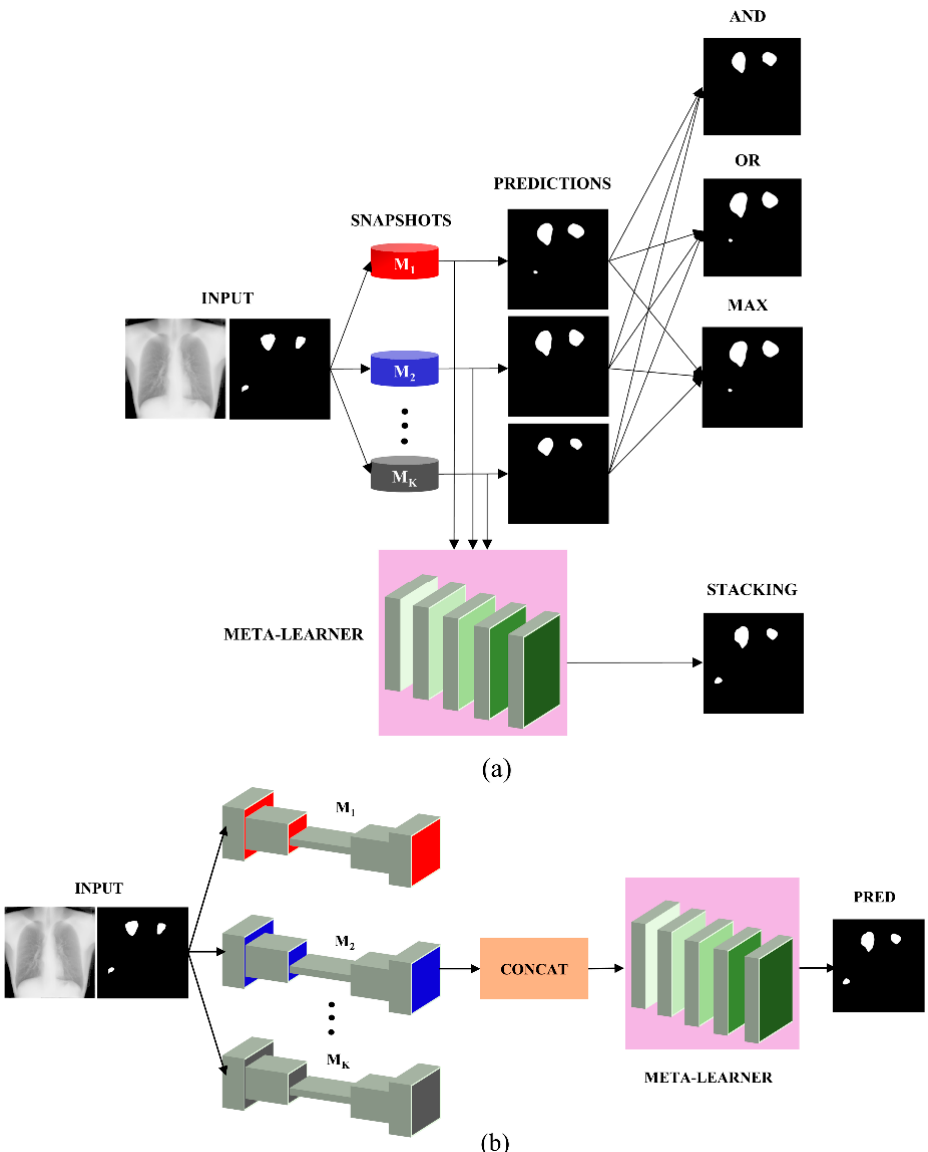
Figure 2. Ensemble strategies using the predictions of top-K (K = 3, 4, 5) models. ( a ) shows the method flowchart showing bitwise-OR, bitwise-AND, bitwise-MAX, and stacking ensemble outputs and ( b ) shows the method flowchart detailing the stacking process.